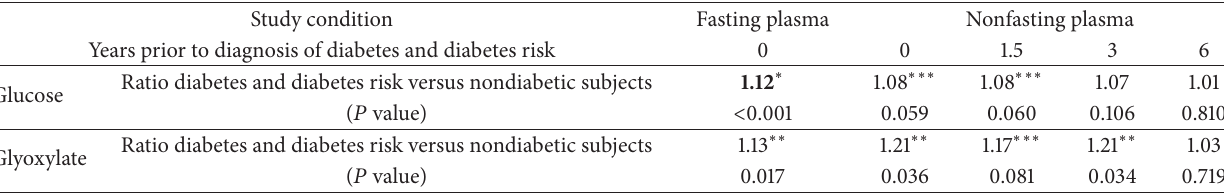
Table 1: Increased plasma glyoxylate levels allow for diabetes diagnosis earlier than plasma glucose. Glyoxylate is significantly increased in blood plasma in type 2 diabetes and starts to rise in nonfasted subjects later diagnosed as prediabetic or diabetic up to 3 years prior to T2D diagnosis. For comparison, corresponding data on glucose changes from the same samples are provided. Significant differences in glyoxylate levels were detectable in fasting as well as in nonfasting plasma samples. Fasting plasma was obtained from diabetes and diabetes risk subjects ( 𝑛 = 301 ) and from age, gender, and BMI matched nondiabetic subjects ( 𝑛 = 177 ) participating in the prospective study; retrospective analyses of samples available (or stored) at the biobank of the Blood Donation Service were from diabetes and diabetes risk subjects ( 𝑛 = 147 ) and from nondiabetic subjects ( 𝑛 = 96 ) of the above described study group.